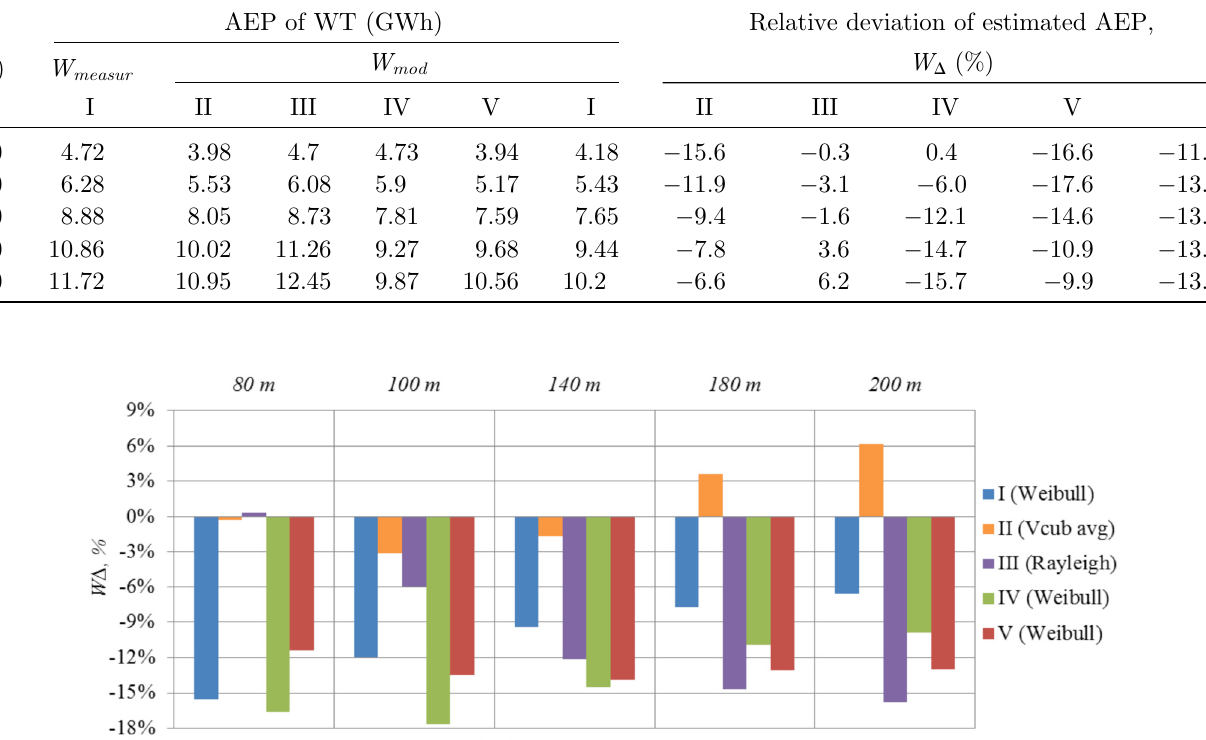
), III (Rayleigh), avg cub